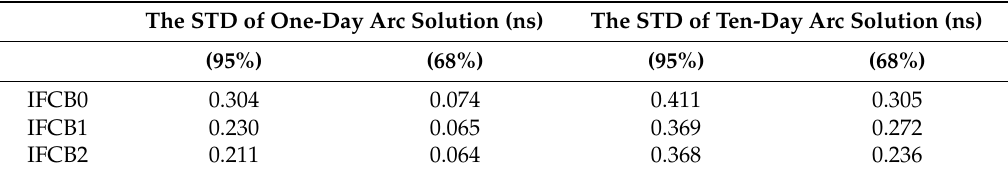
Table 7. The uncertainty (STD) of the GLONASS PPP solutions without fixed coordinates (ns). The STD of One-Day Arc Solution (ns)